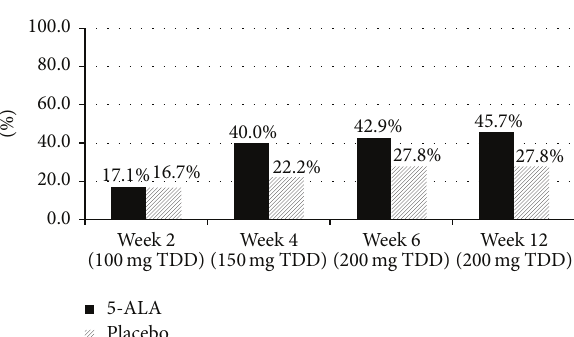
Figure 2: Cumulative adverse events reported at each visit. Patients in both groups experienced a decrease in weight from baseline to week 12, with a decrease of − 0.2 kg in the 5-ALA group and − 0.8 kg in the placebo group ( 𝑝 = 0.243 ). Mean and change from baseline HbA1c levels are pre- sented in Table 5 and Figure 3. There was no statistically significant difference in HbA1c between the two groups. A post hoc analysis showed a significant decrease in HbA1c levels from baseline in both groups in the ITT population at